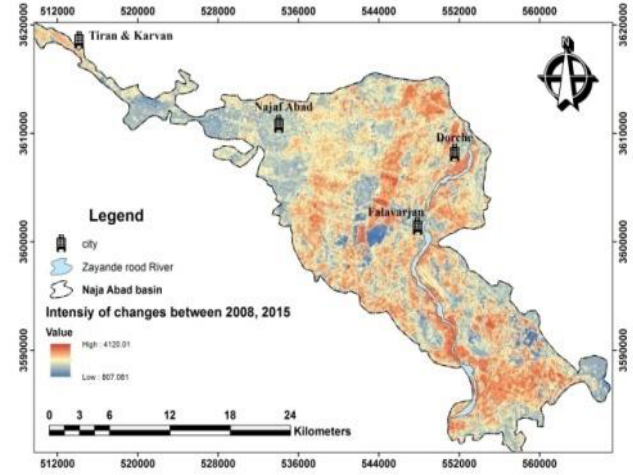
Figure 4. Change Vector image 2008-2015 (background scene: Brightness image 2008)